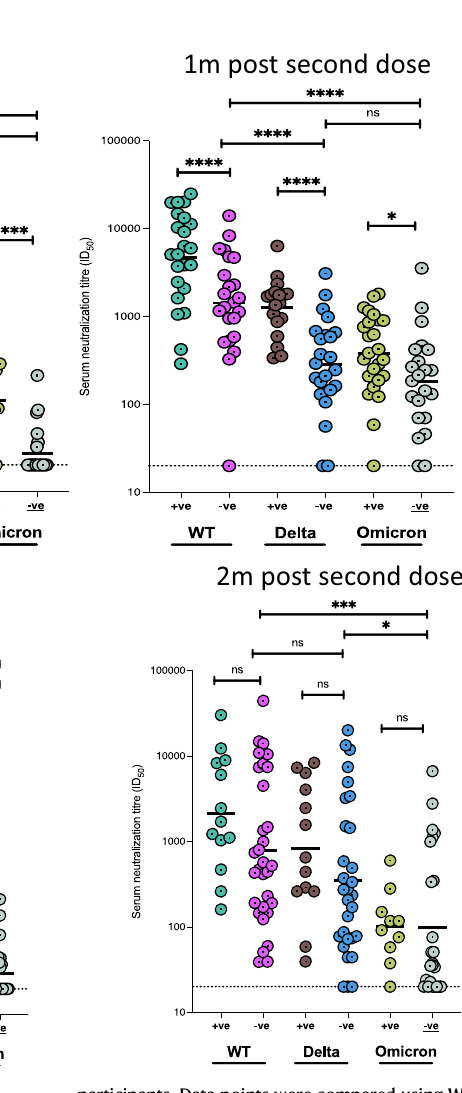
participants. Data points were compared using Wilcoxon test and shown as geo- metric mean titre (GMT) with 95% CI. Data are representative of two independent experiments comprising of two technical replicates. * P <0.05; ** P <0.01; *** P <0.001; **** P <0.0001; ns=not signi fi